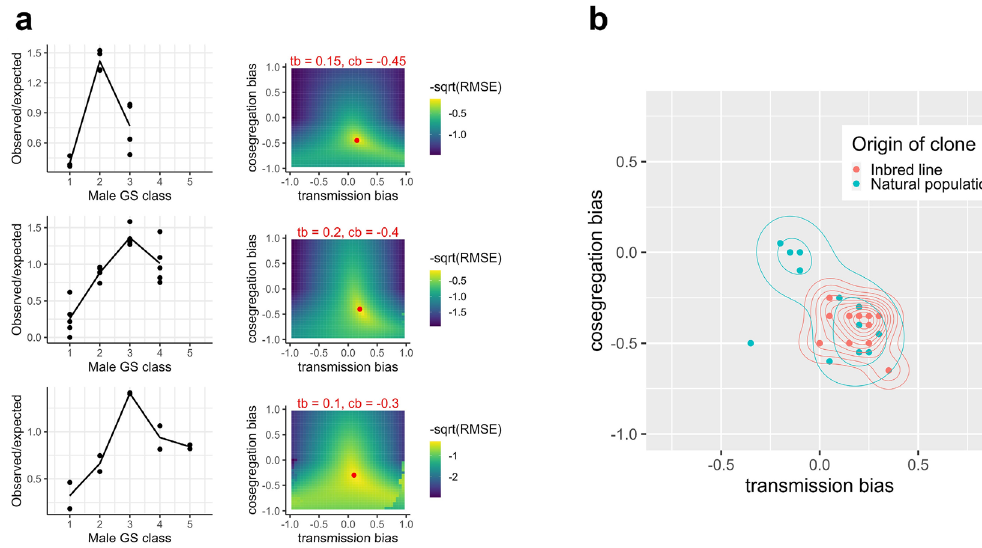
Figure 4. Estimation of meiotic transmission parameters. ( a ) Least-squares estimation of the optimal parameter values for transmission bias (tb) and cosegregation bias (cb) based on empirical GS data (hatched males) from an inbred laboratory line. Left: Empirical data (Clonal means indicated by dots and means across clones indicated by lines). Right: Model fitted to the means (across clones) of each genome size class. The best combination of transmission bias and cosegregation bias with the lowest residual mean square error (RMSE) is indicated by a red dot. ( b ) The same fitting procedure was applied to genome size data of hatched males of 11 rotifer clones from the inbred line and 12 outbred clones. Dots correspond to the least-squares estimations of the optimal parameter values for the different clones in Supplementary file 3. Contours are 2D kernel density estimations for inbred and outbred clones (function: geom_density_2d of the R-package ggplot2